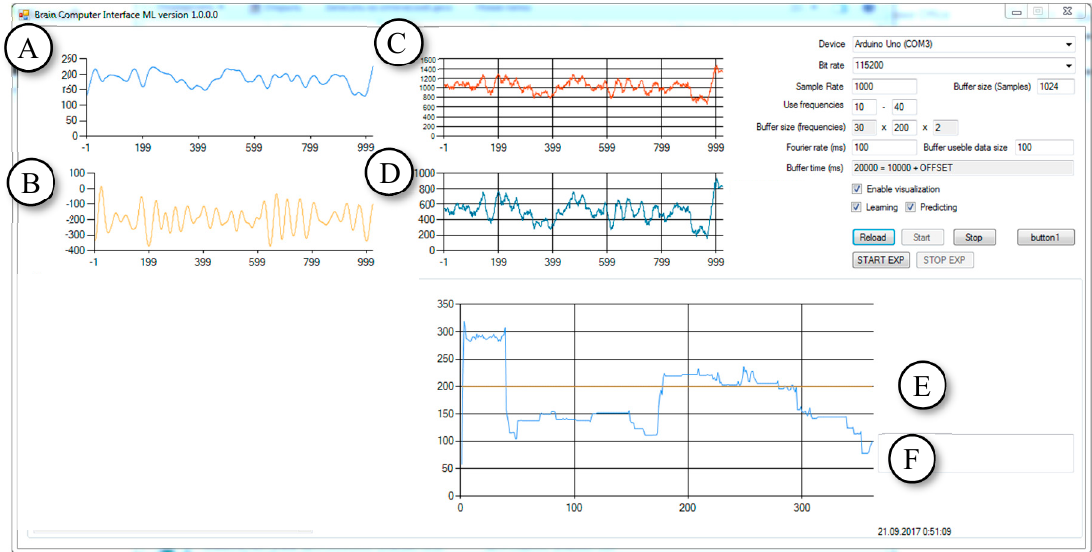
Figure 7. The Brain Computer Interface ML Version 1.0.0.0 program evaluates the amplitude of the alpha rhythm. (Experiment eyes open (EO)/eyes closed (EC). Light blue ( A )—alpha waves. Yellow ( B )—beta 1 waves. Red ( C ) and cyan ( D ) are raw EEG in a different scale. Yellow ( E )—graph displaying the status of the experiment in accordance with the scale of the A/EEG ratio graph. Light blue ( F )—alpha/raw EGG amplitude ratio (multiplied by 1000). (Opened eyes—value is 100, closed eyes—value is 200).